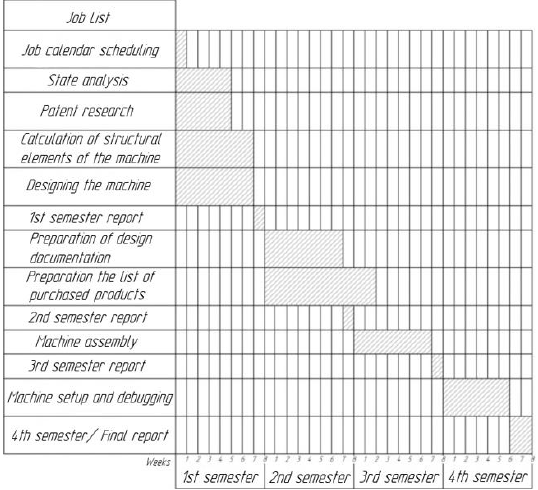
Fig. 1. An approximate version of the schedule of the list of